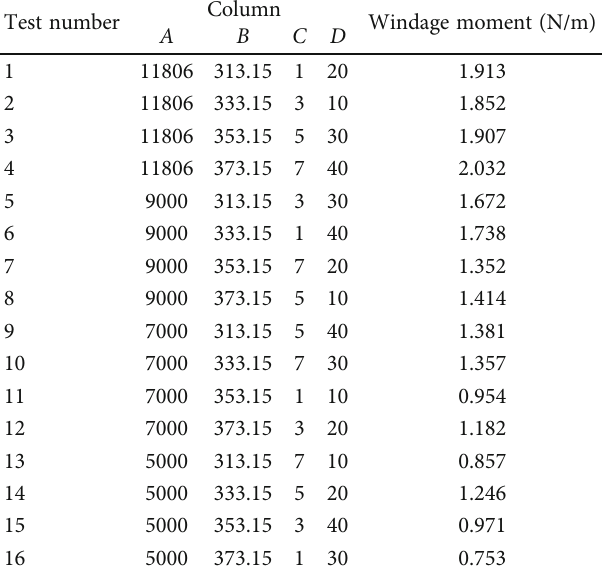
Table 6: Experiment scheme and result.